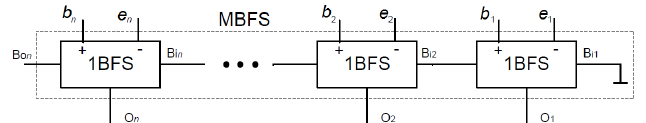
Figure 8. Multi-bit full subtractor used in the proposed neighborhood mechanism as a substitute of te former R_PROP decrementing block.